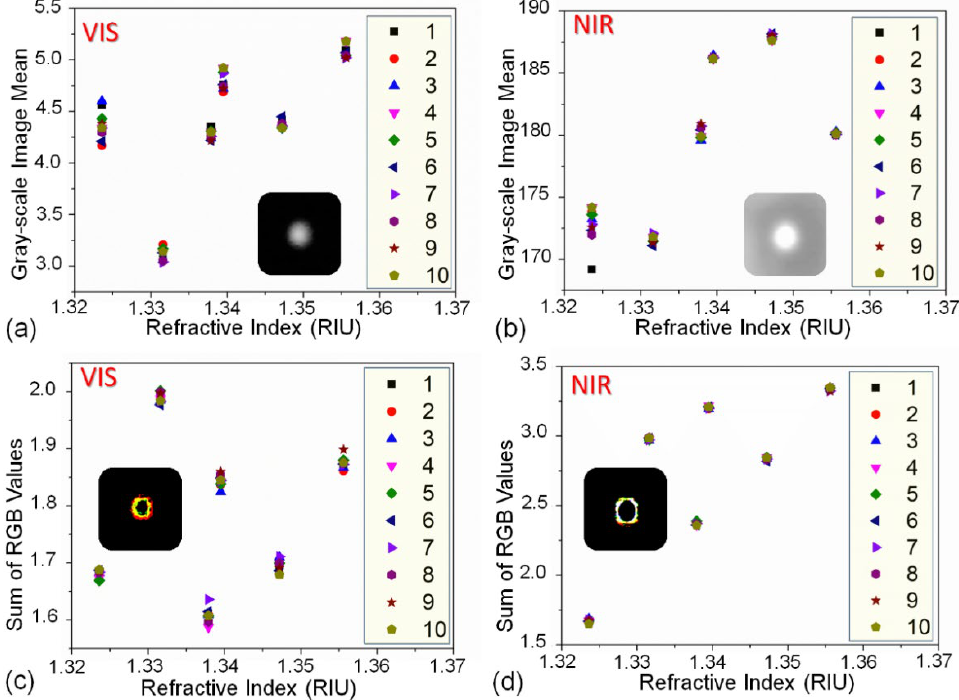
Figure 3. Grayscale mean of the VIS ( a ) and NIR ( b ) light spot images at different RIs. RGB summation of the edge detection images of VIS ( c ) and NIR ( d ) light spot at different RIs. In order to avoid the influences of different data sets when verifying the proposed method, we selected 45 data sets from all 60 data sets as training sets. The remaining 15 data sets were determined as test sets. The test sets were randomly characterized in this work. We randomly divided 45 training sets and 15 test sets into a total of 60 data sets each time. The expected values in Figure 4 are the RIs of the sodium chloride solution samples flowing into the flow cell during the experiments. The RIs of the samples were measured by an Abbe refractometer. Besides, to explore the effects of the four types of input (the grayscale means of VIS and NIR images and RGB summation of the edge detection images) on the BP neural network output, we used only the grayscale mean dataset of VIS images as the input to the BP neural network firstly. The BP neural network results are shown in Figure 4a–d where the abscissa represents the test data set and the ordinate represents the corresponding RI value. We calculated R 2 , the coefficient of determination, as an indicator of the difference between the test results and the expected results. As